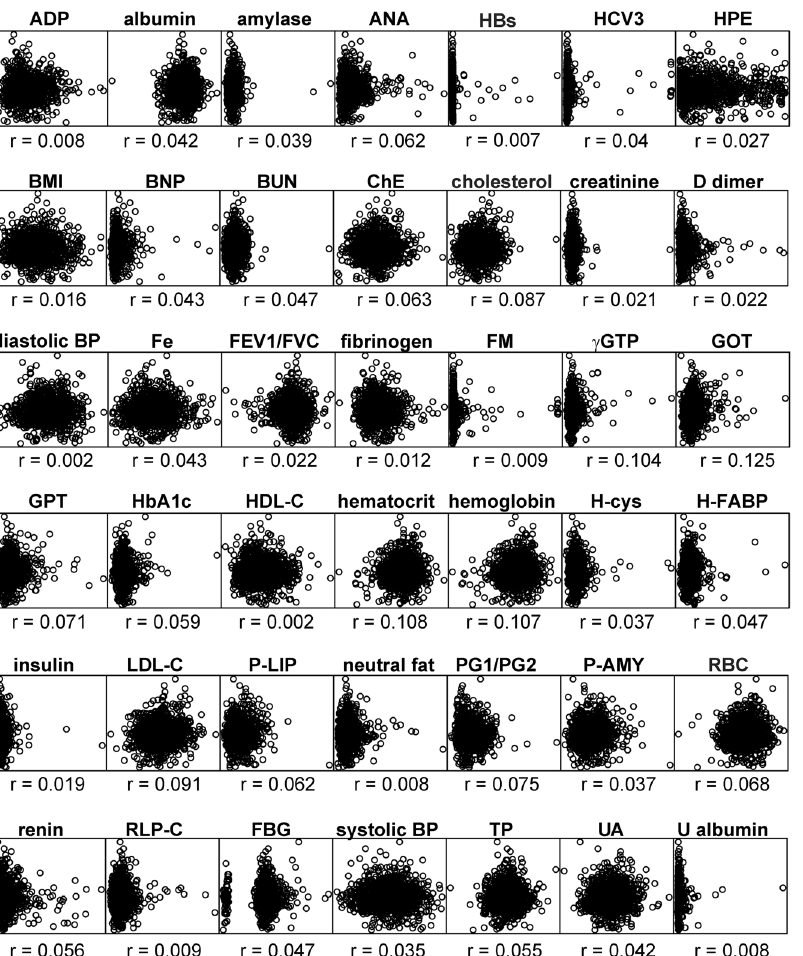
Figure 6. Scatter plots of the ACE levels with each of the other clinical test values in the Takahata population. These plots show no strong correlation of each of other phenotypes to ACE. Each r denotes Pearson’s (product-moment) correlation coefficient. The names and abbreviations of the total of 43 quantitative values are same as Figure 5.